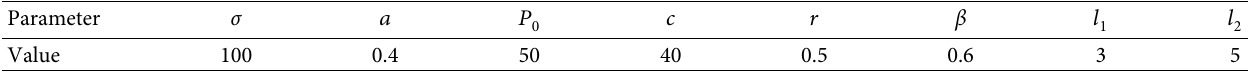
Table 4: Parameter assignment.